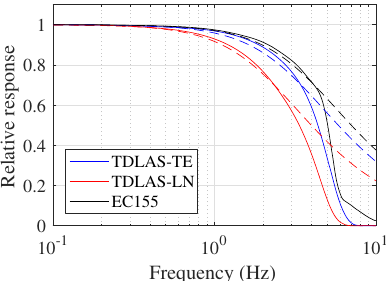
Figure 4. Results of the frequency-response test of TDLAS-LN and TDLAS-TE for N 2 O and the EC155 (CO 2 ) under normal operating conditions (solid lines); dashed lines are modelled T FR calculated using the measured f c in Eq. (1).